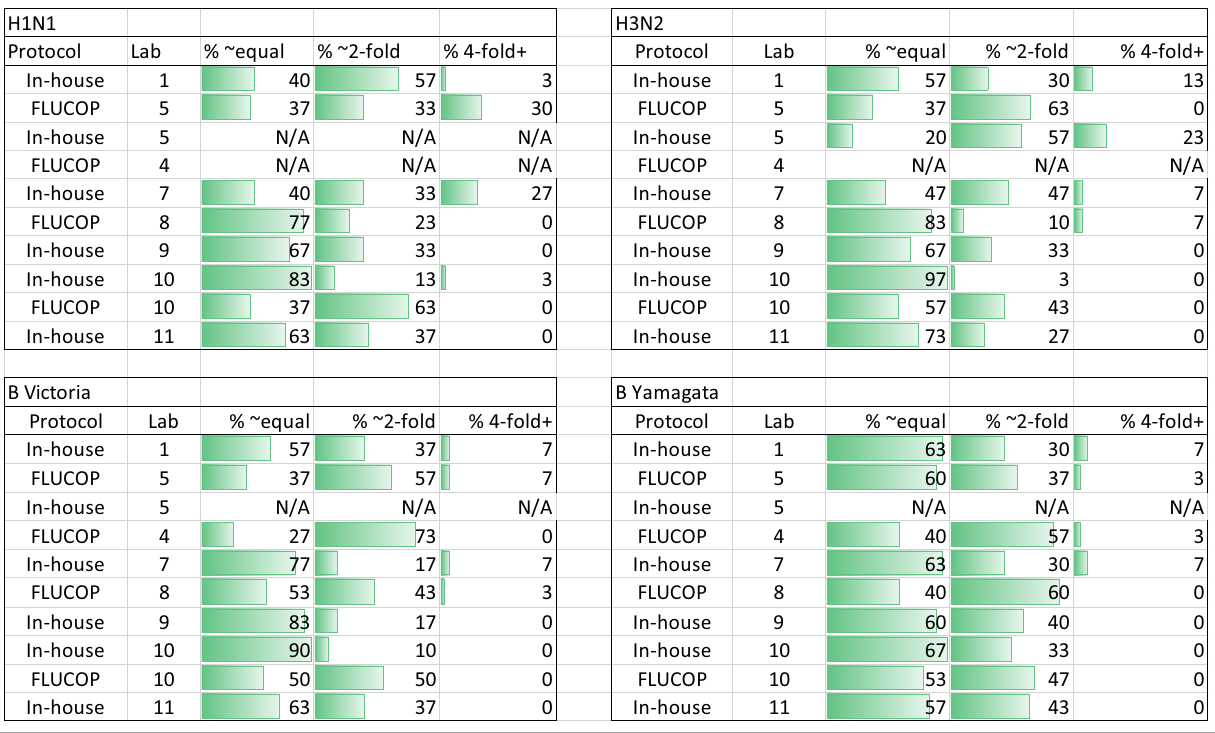
TABLE 2 MN Intra-laboratory variation - % maximum to minimum ratios across at least 2 replicates. H1N1